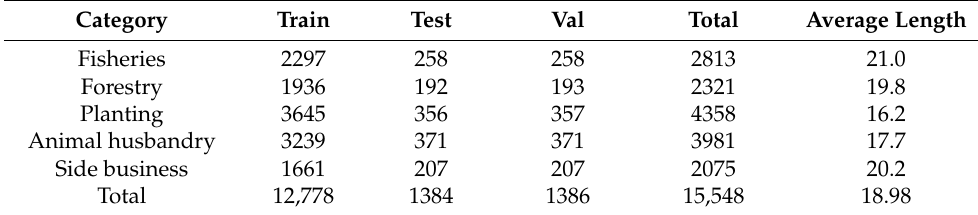
Table 1. Details of the data set.